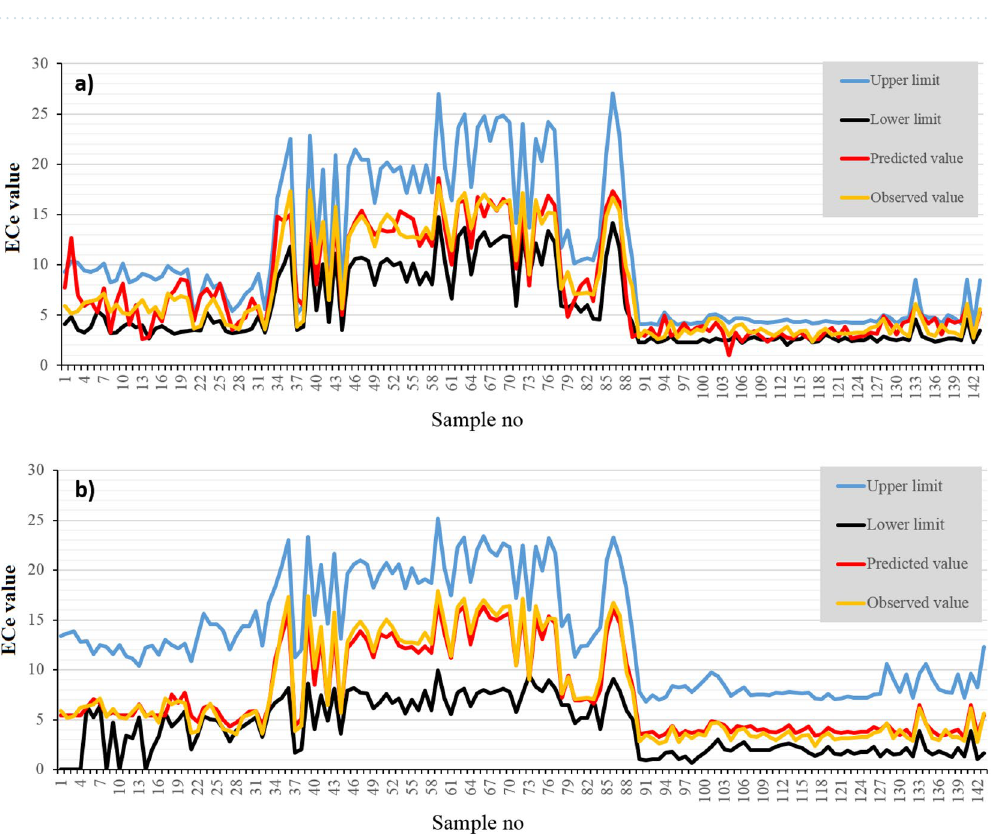
Figure 7. The uncertainty associated with the ( a ) DBM model and ( b ) 1DCNN-LSTM hybrid model estimated using